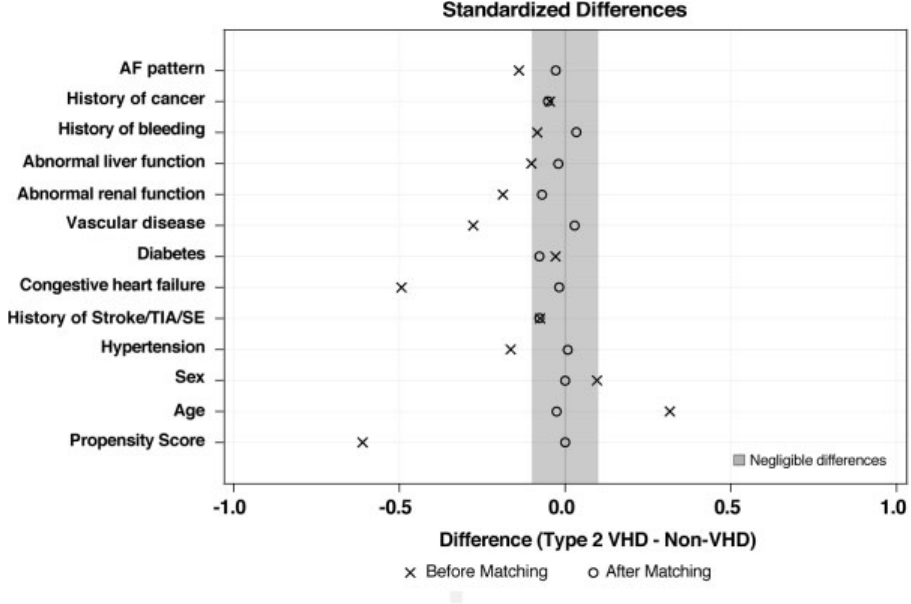
Fig. 3 Standardizedmeandifferencesplotbeforeandaftermatching.Alldifferencesforthematchedobservationsarewithinthebalancelimitsof – 0.1and 0.1 which are indicated by the shaded area. AF, atrial fi brillation; SE, systemic embolism; TIA, transient ischemic attack; VHD, valvular heart disease.